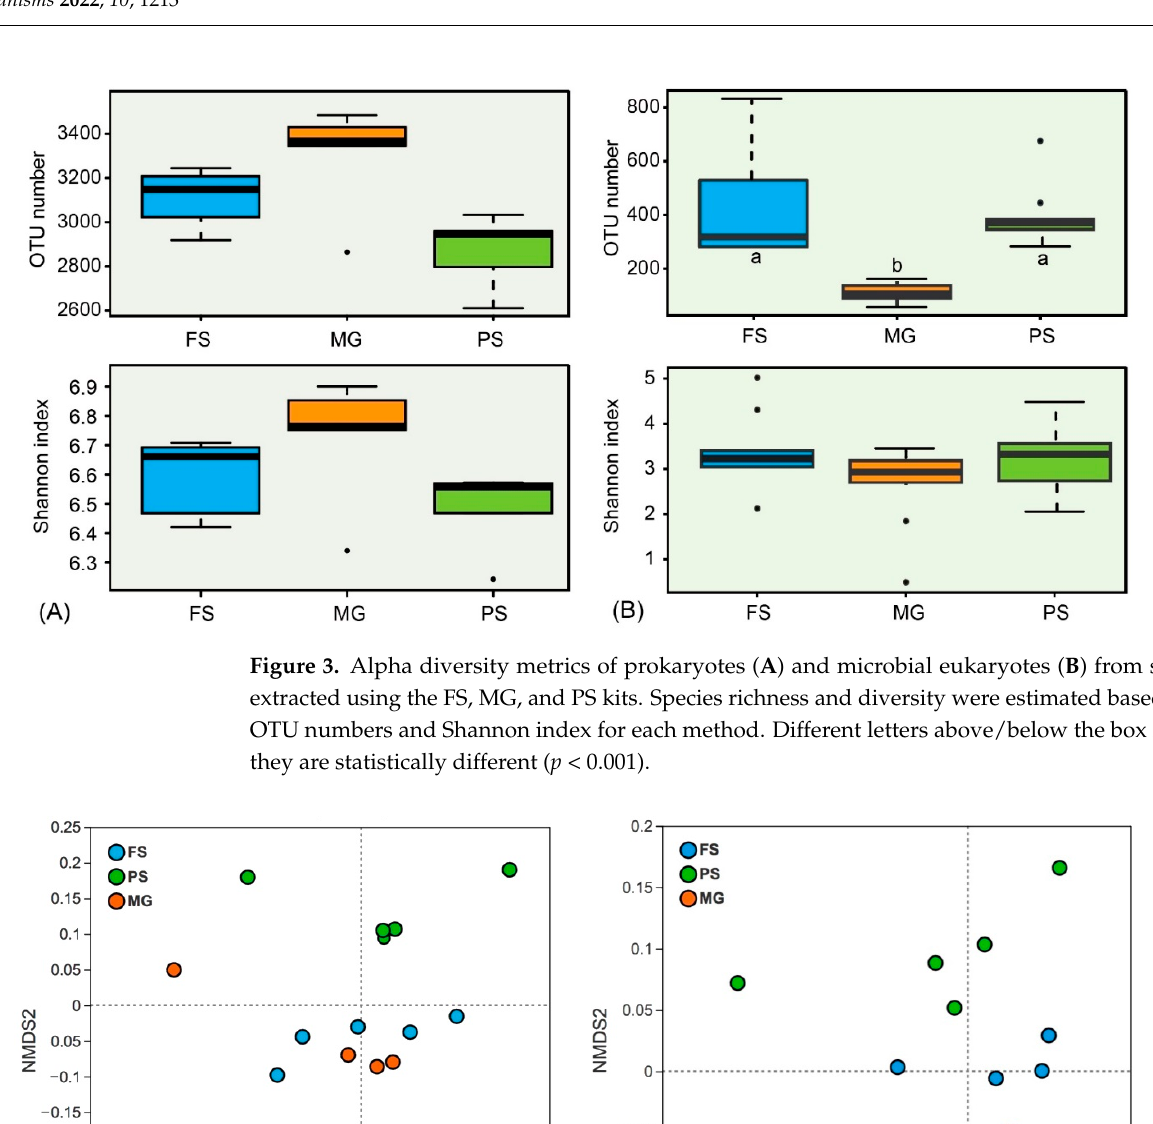
Figure 3. Alpha diversity metrics of prokaryotes ( A ) and microbial eukaryotes ( B ) from samples extracted using the FS, MG, and PS kits. Species richness and diversity were estimated based on the OTU numbers and Shannon index for each method. Different letters above/below the box indicate they are statistically different ( p < 0.001).